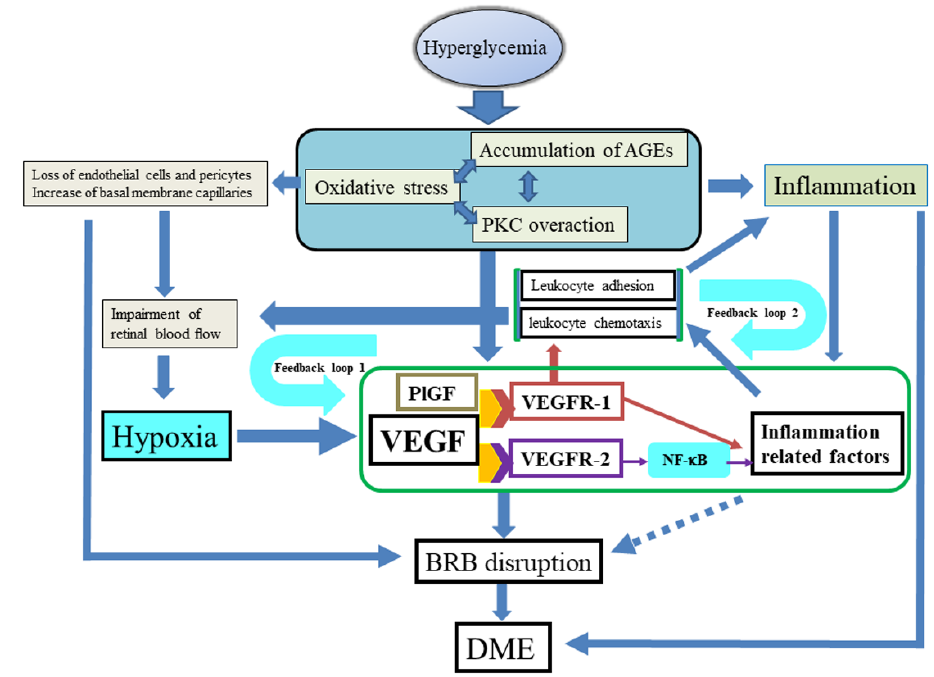
Figure 4. Hypothesized pathogenesis of diabetic macular edema. Hyperglycemia can lead to oxidative stress, formation of advanced glycation end-products (AGEs), and activation of protein kinase C (PKC). These abnormalities in biochemical pathways could induce the expression of vascular endothelial growth factor (VEGF), loss of endothelial cells or pericytes, an increase of basal membrane capillaries, and inflammation. The loss of endothelial cells and pericytes and increase in basal